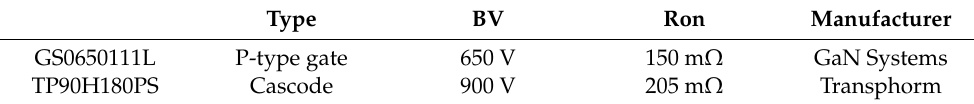
Table 1. Parameters of the device.